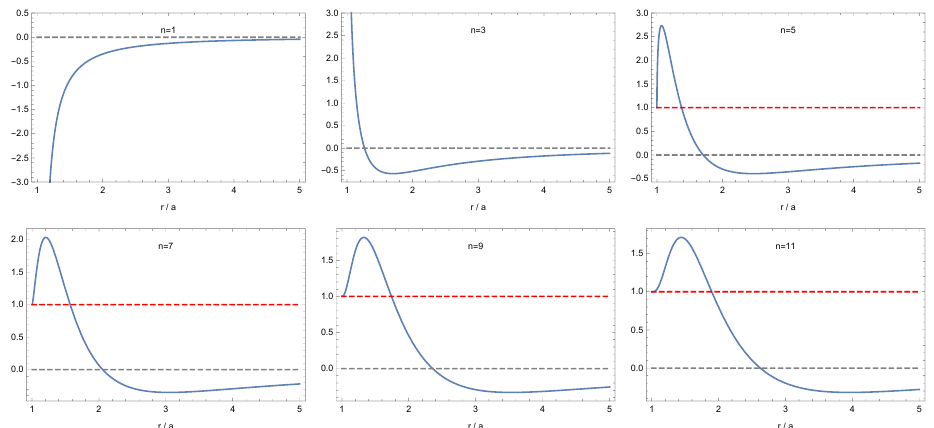
Figure 1. Plots of the NEC for several values of n . Here, the y -axis depicts 8 π r 2 ( ρ + p ⊥ ) , plotting against r / a on the x -axis. Of particular interest are the qualitative differences in behavior as r / a → 1; we see divergent behavior for the n = 1 and n = 3 cases, whilst, for n ≥ 5, we see 8 π r 2 ( ρ + p ⊥ ) → 1 as r → a . This is ultimately due to the fact that the n ≥ 5 cases are curvature regular , with globally finite stress-energy